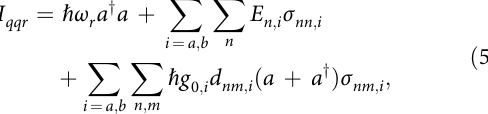
is maximized. Here we assume no coupling to 01